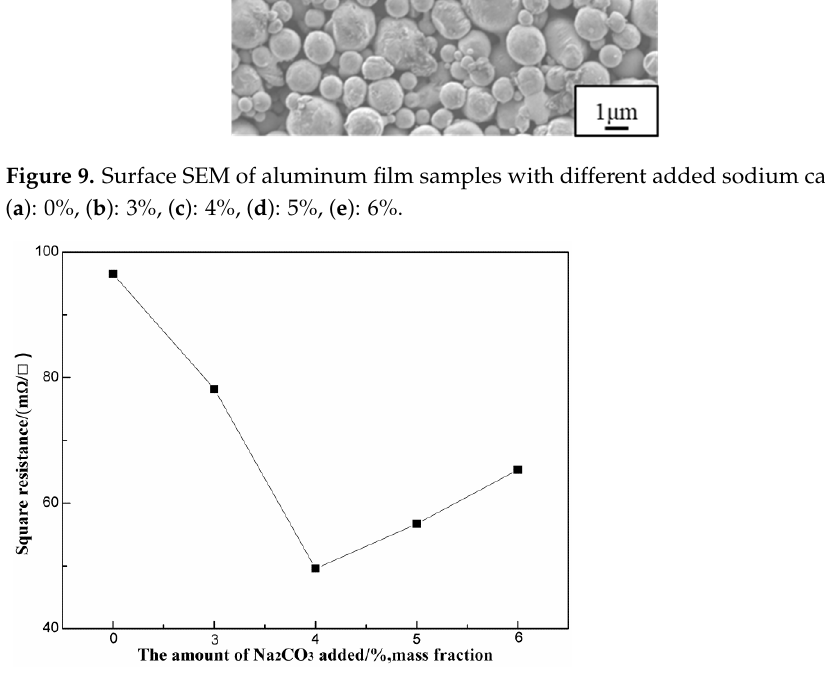
Figure 10. Effect of sodium carbonate content on the square resistance of aluminum electrode specimens.